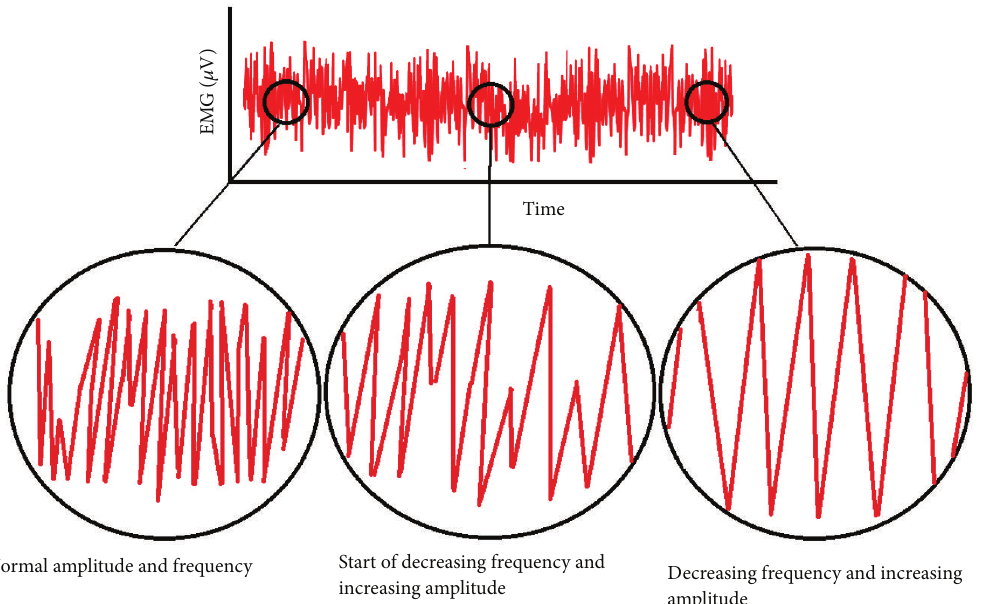
Figure 1: Schematic of changes in EMG data during muscle